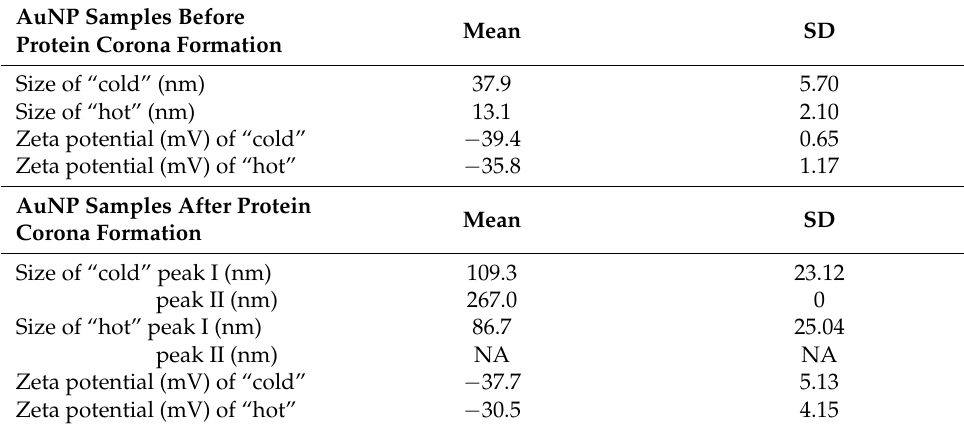
Table 1. The obtained size distribution by number (nm) and zeta potential (mV) of two different “cold” and “hot” AuNP samples in 3 (size) to 5 (zeta potential) replicates. Size and zeta potential of AuNP samples after incubation with 55% plasma in different replicates are shown and compared here. NA stands for not